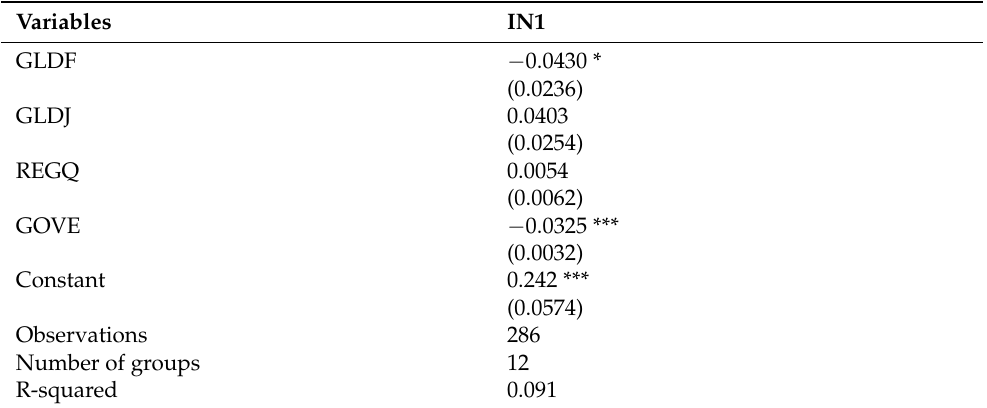
Table 12. Model 2. Income Share of the Top 1% (IN1).